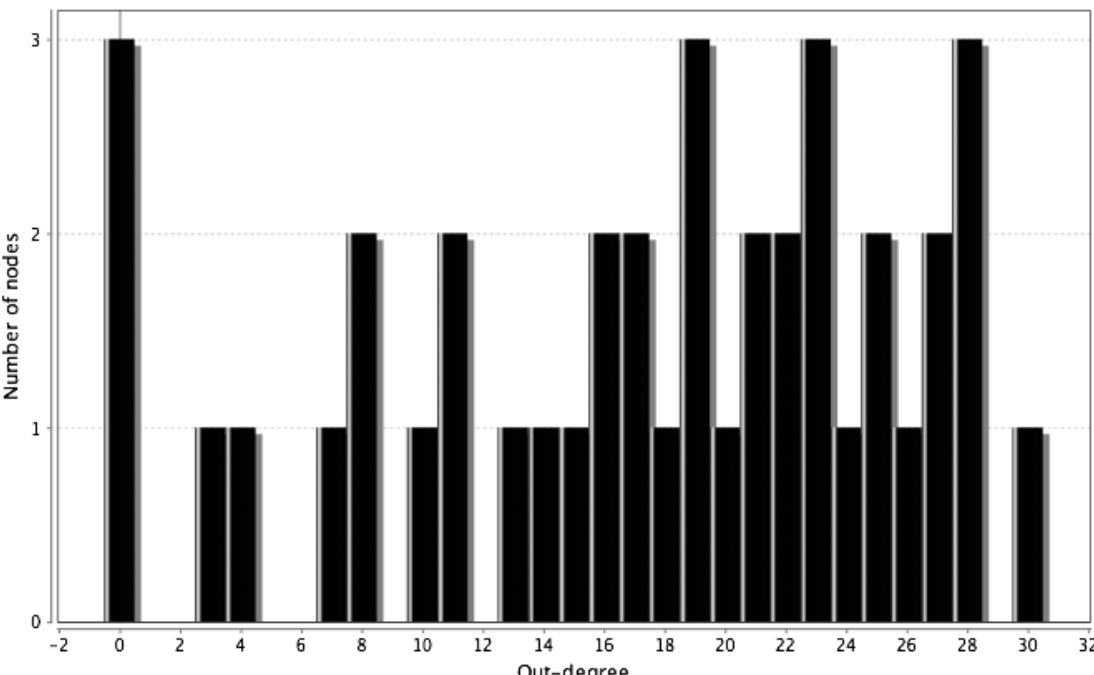
Figure 16 . In-degree (A) and out-degree (B) distribution of all the members in the Apps conversational network.